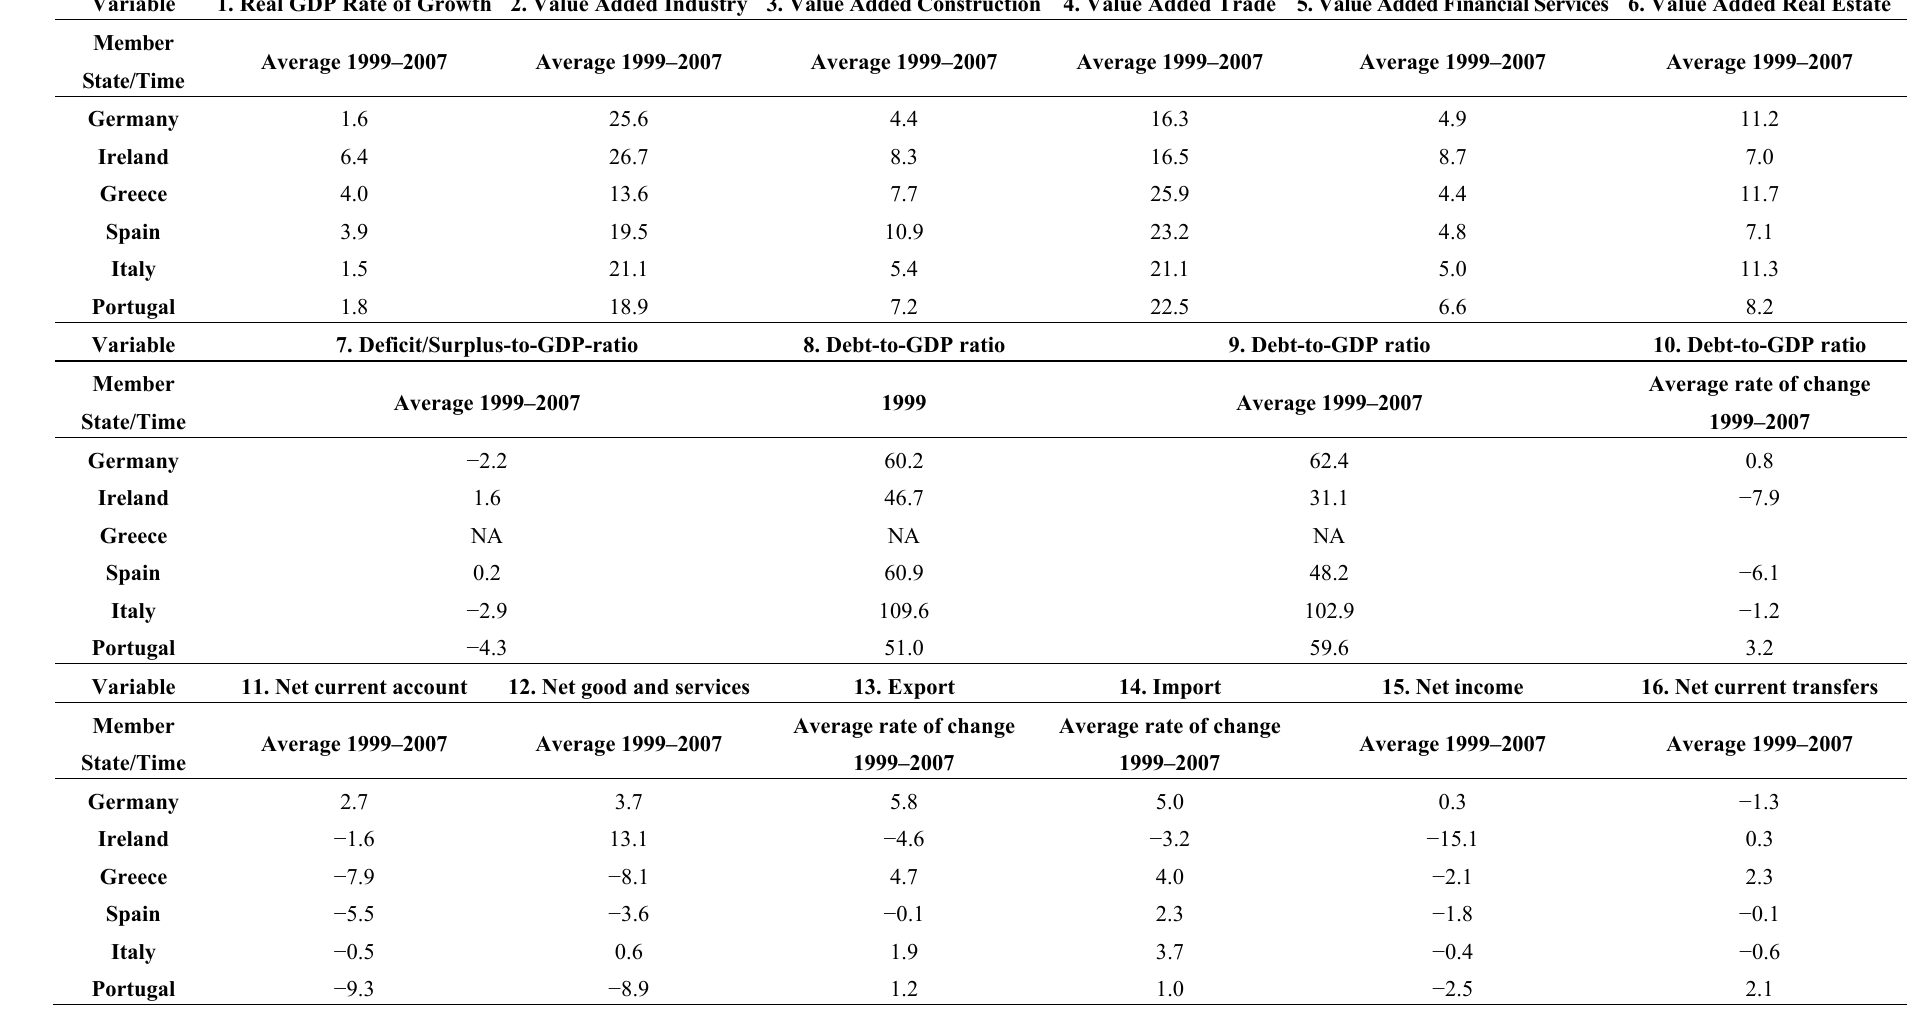
Table A1. Macro indicators of internal and external